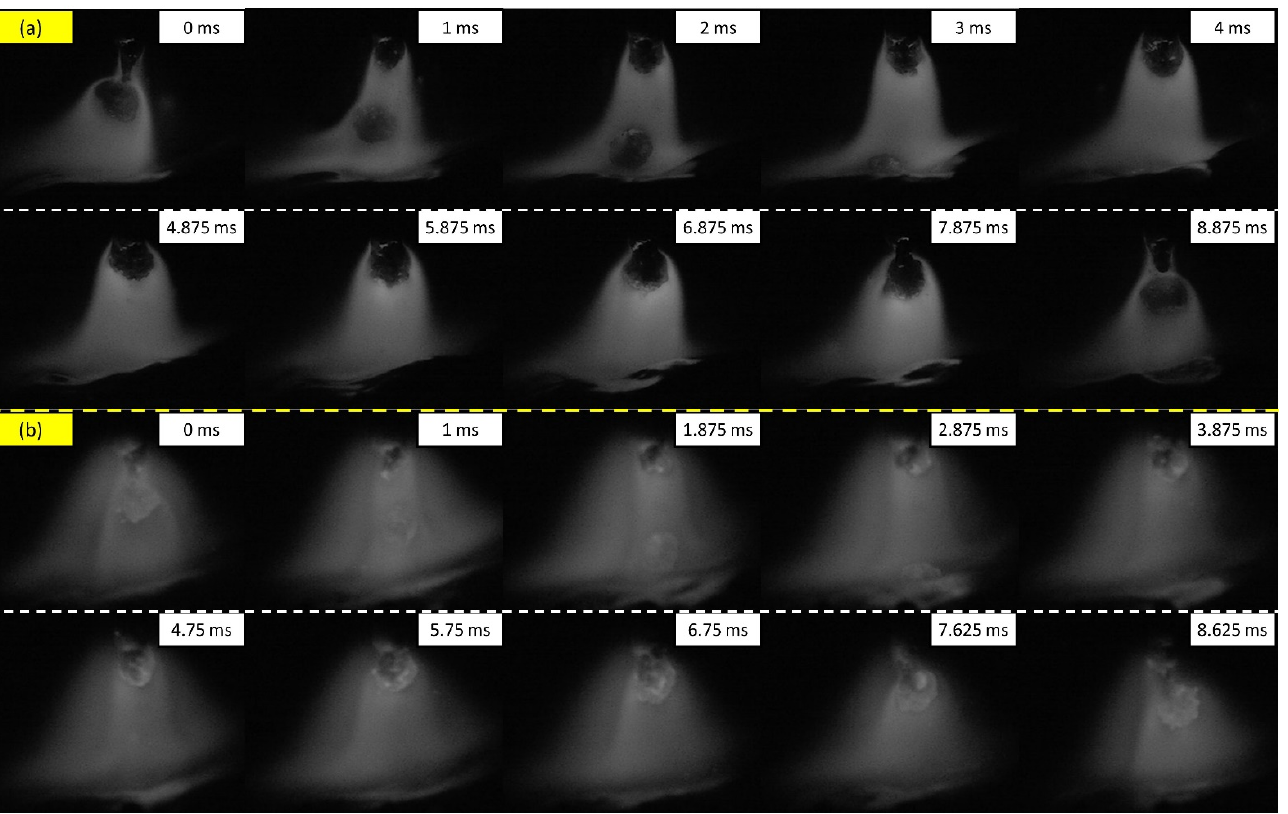
Figure 6. Sequential video images observed with Fe I filter ( a ) and Ar I filter ( b ) of metal ‐ cored wire at 280 A welding current.